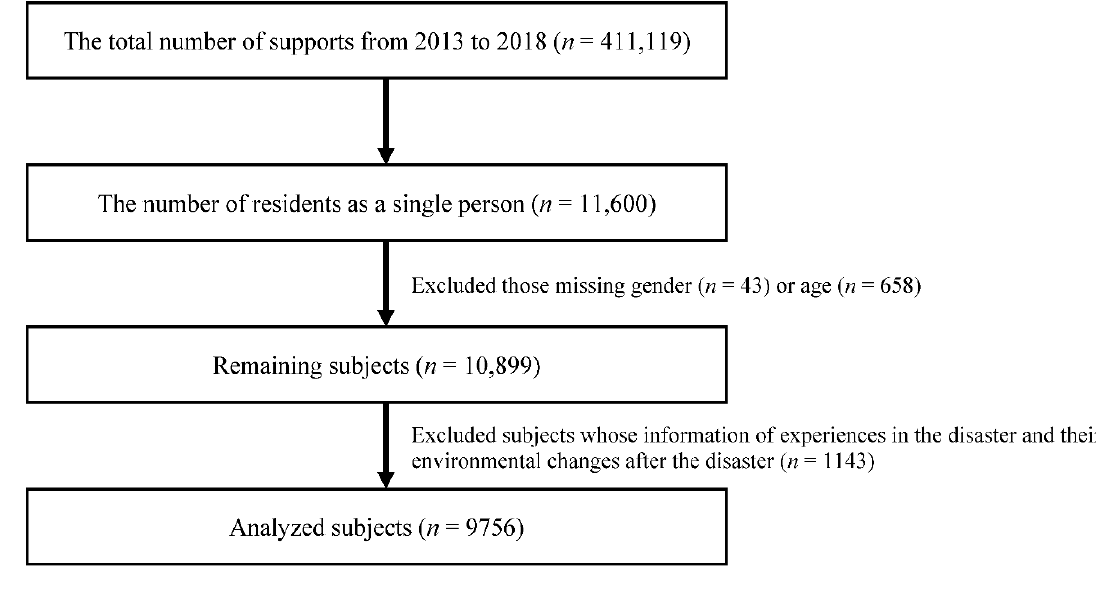
Figure 2. Sample selection from the Miyagi DMHCC database.